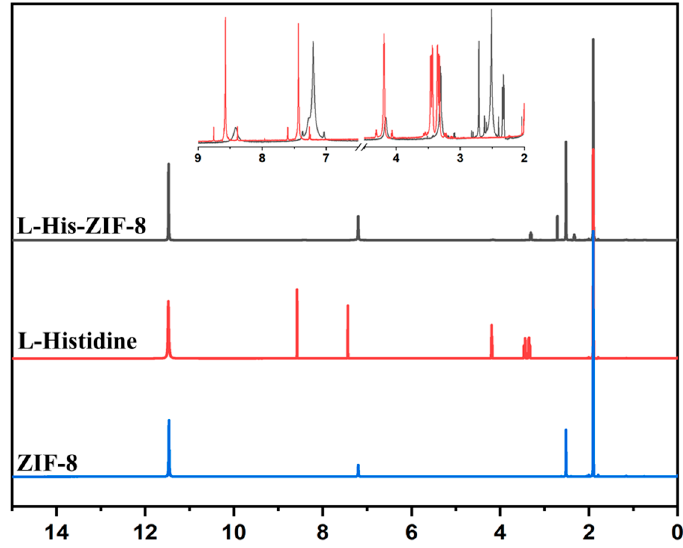
Figure 4. 1H NMR Spectrum (600 MHz, CD3COOD) of the ZIF-8, L-Histidine and L-His-ZIF-8 .